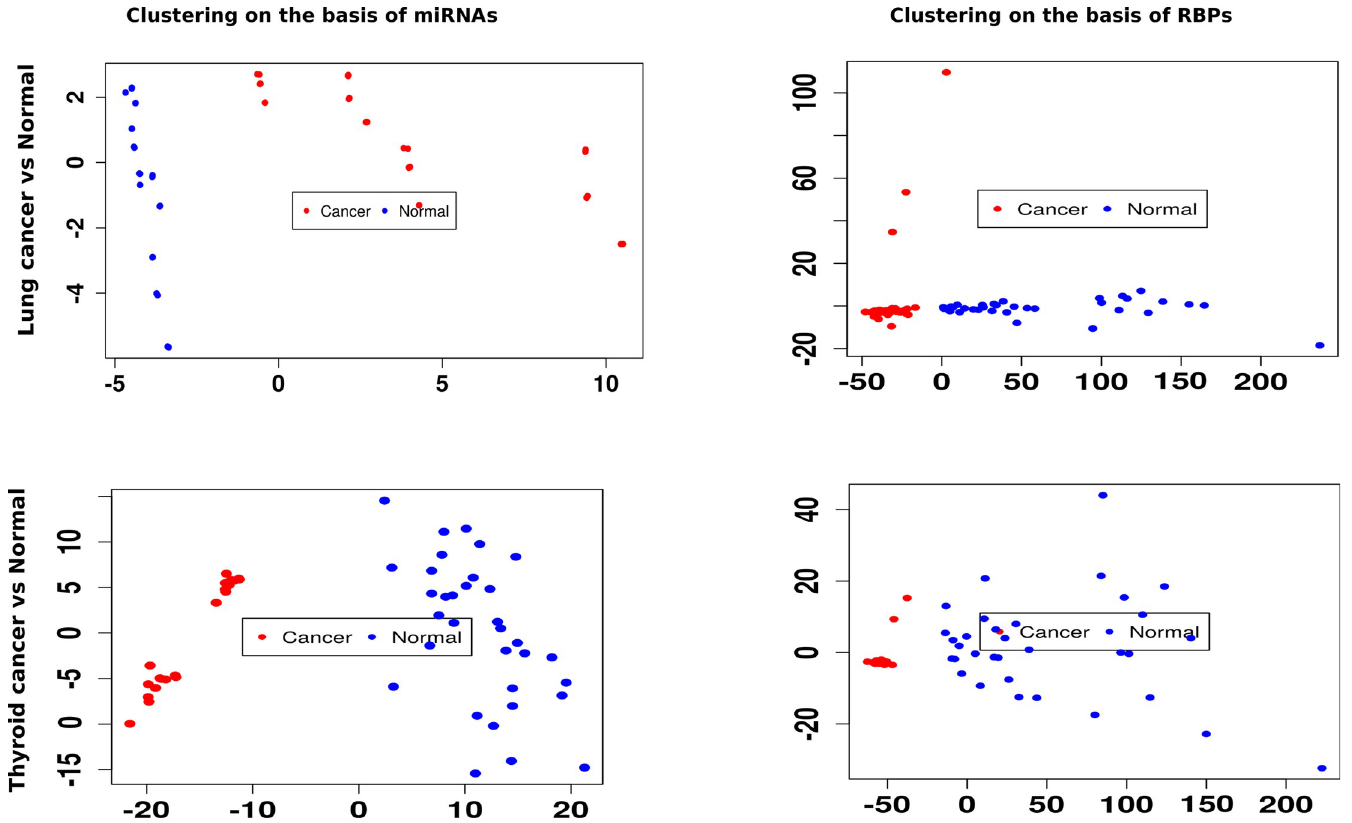
Fig 5. miRNAs and associated RBPs distinguish between cell lines similarly. This set of plots displays the discrimination between lungs cancer vs normal samples and thyroid cancer vs normal samples based on k-means clustering on miRNAs and associated RBPs, separately. The associated miRNAs and RBPs gave similar results, reflecting their functional